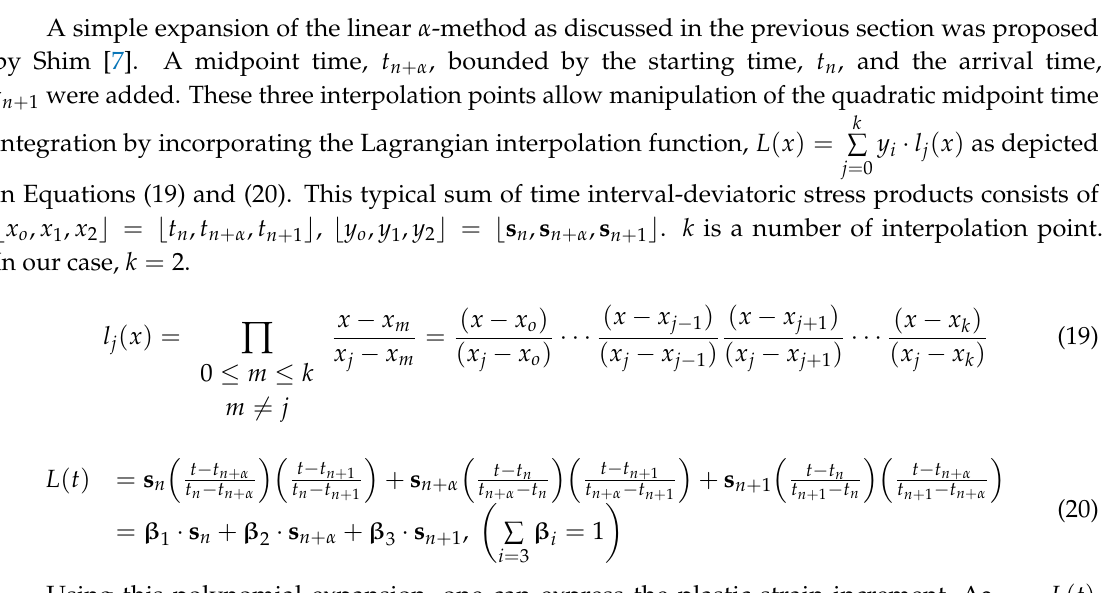
Figure 6. Solution algorithm for radial return method and linear generalized trapezoidal method in J 2 plasticity (rearranged and cast by the author from Simo et al. [4,5]), Note: K is the bulk modulus and k is the iteration number.